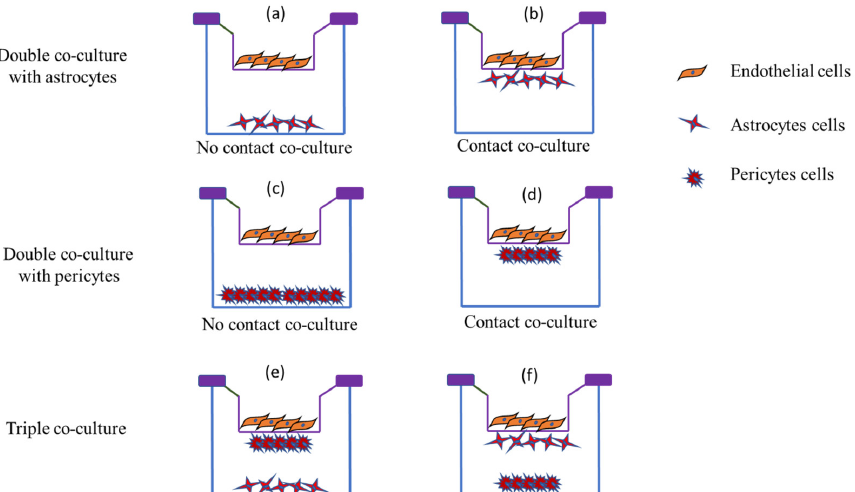
Figure 3. Schematic representation of different in vitro co-culture models in BBB demonstrating double co-culture and triple co-culture. Endothelial cells, astrocytes, and pericytes are the cells utilized for barrier formation. ( a , c ) represent no contact co-culture of endothelial cells with astrocytes and pericytes, respectively, while ( b , d ) represent endothelial cell contact co-culture with astrocytes and pericytes, respectively, and ( e , f ) represent triple co-culture where abluminal cells in contact with endothelial cells differ. ( e ) represents pericytes in contact with endothelial cells with astrocytes at the bottom of the cell, whereas ( f ) represents astrocytes in contact with endothelial cells and pericytes at the bottom of the